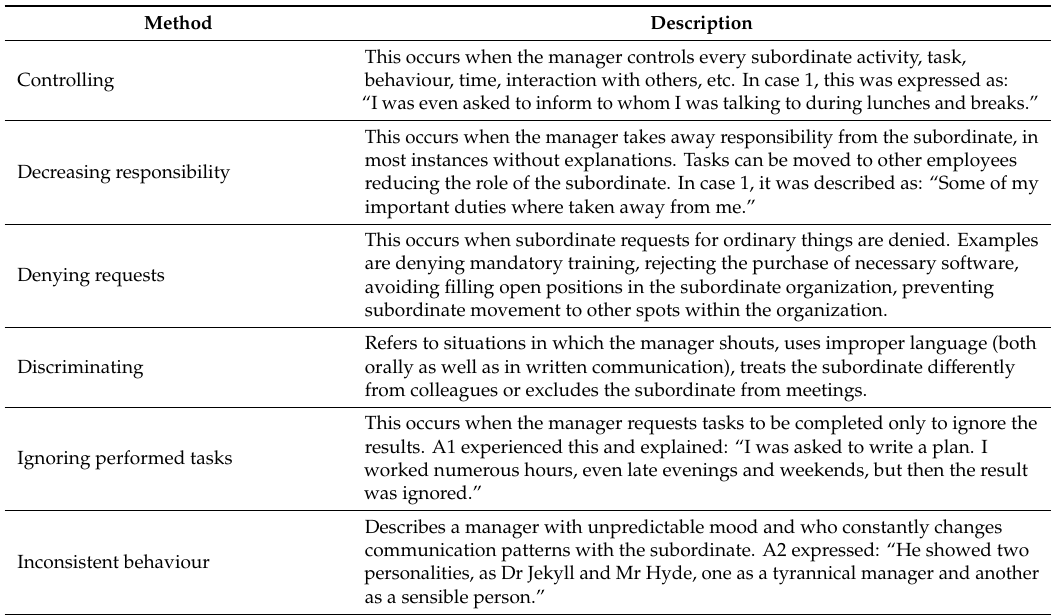
Table 3. Power methods of